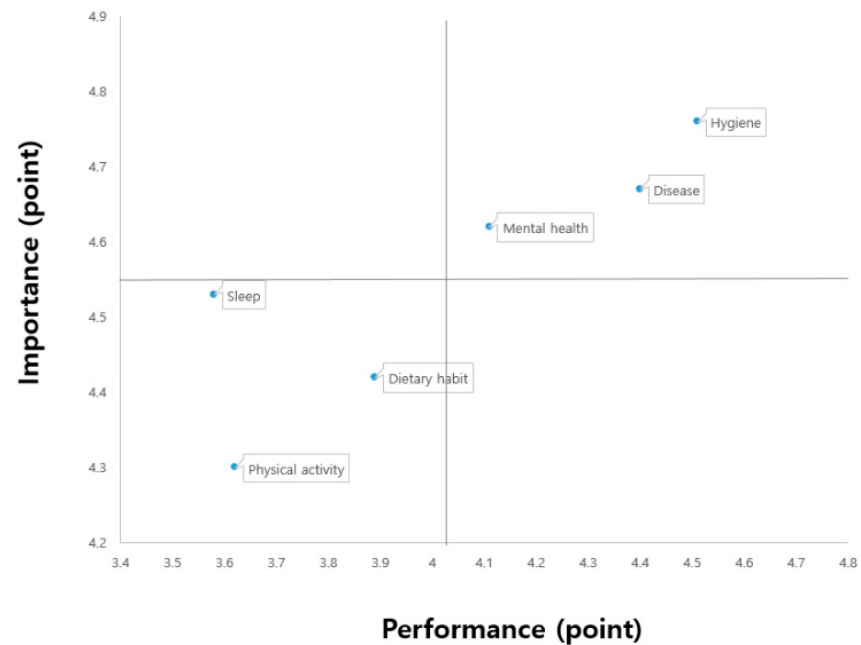
Figure 1. K middle school with assignment-based online PE classes.